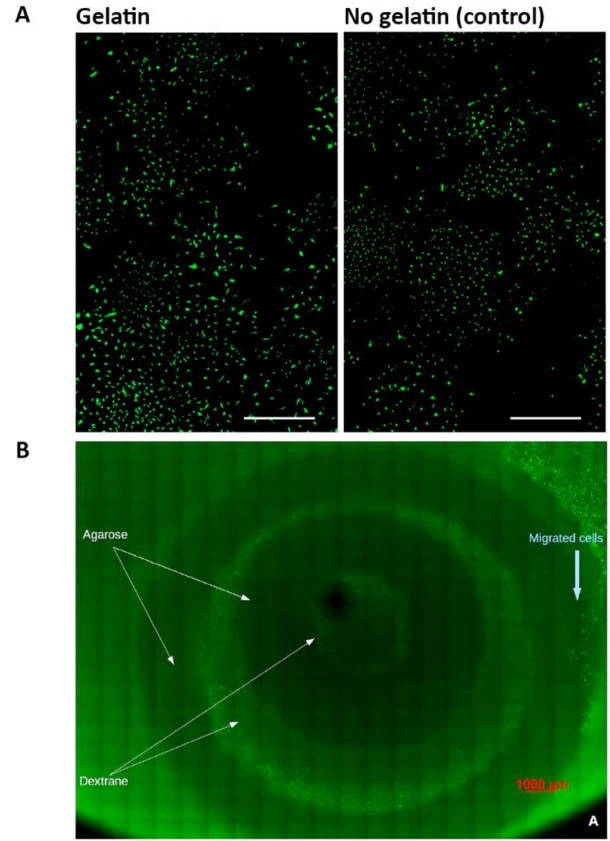
Figure 7. Representative fluorescence images taken during the cytotoxicity test of gelatin crosslinked with caffeic acid and of architecture 1 fabricated from agarose and a dextran-based hydrogel seeded with human chondrons and mechanically loaded . ( A ) presents images of human chondrocytes that were incubated with or without gelatin contact to assess cell survival on day 11, using live-dead imaging. Scale bar: 1000 µ m. ( B ) presents a fluorescence image of human articular chondrons within architecture 1 that was fabricated from 5% agarose used as a harder biomaterial and from a dextran-based hydrogel seeded with human chondrons used as soft, cell-loaded biomaterial. The image was taken on day 8 after the model system was mechanically loaded on day 7 with a total strain ranging from 0 to 10%. Number of wells with and without gelatin contact: n = 6 each, number of mechanically loaded architectures: n = 3, number of control architectures: n =